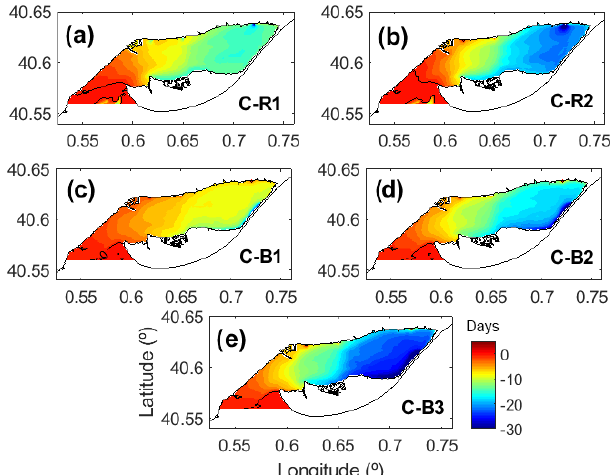
Figure 5. Differences (in days) for the water e -flushing times be- tween each test case and the control simulation (C). Negative (pos- itive) indicates shorter (longer) local e -flushing times for the corre- sponding test compared with C.